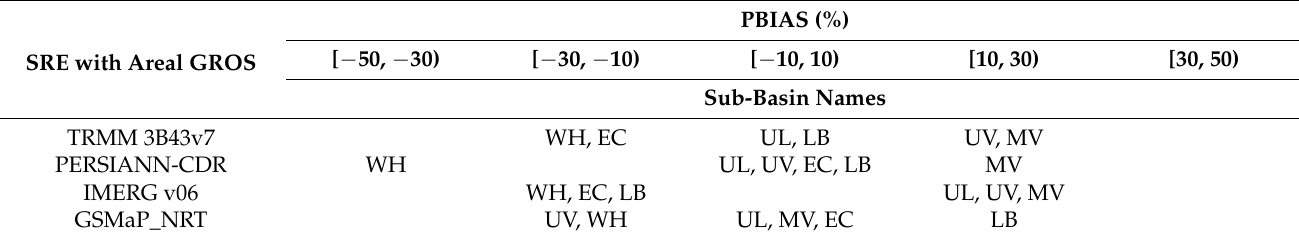
Table 5. Sub-basin cluster with percent bias (PBIAS) distribution.